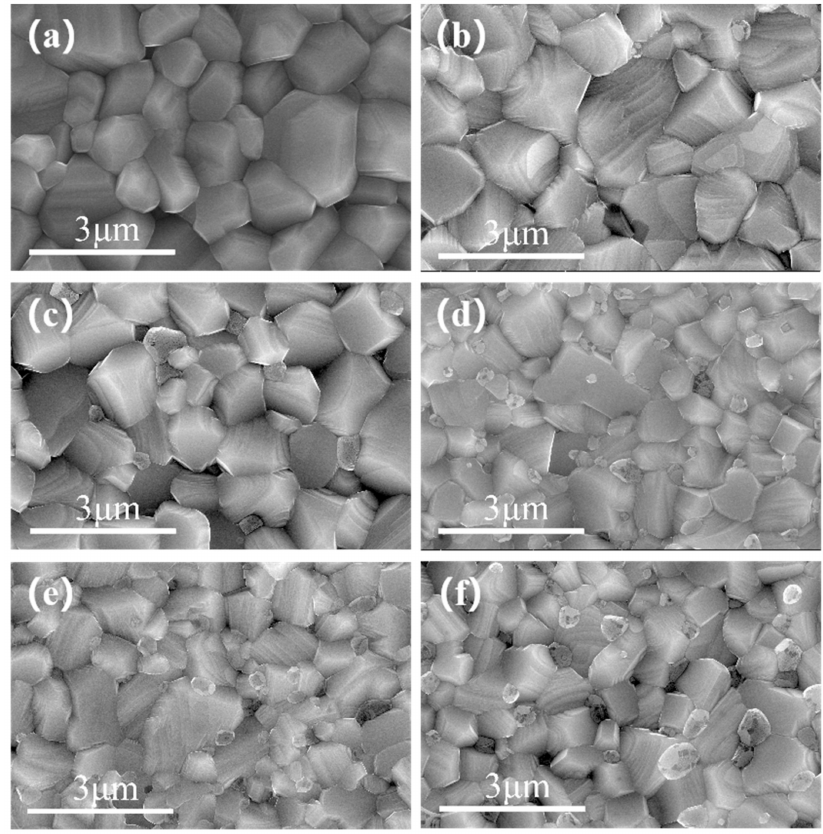
Figure 6. SEM images of the BST and BST- x mol% MgO ( x = 1, 2, 3, 4, 5) ceramics: ( a ) BST, ( b ) x = 1,